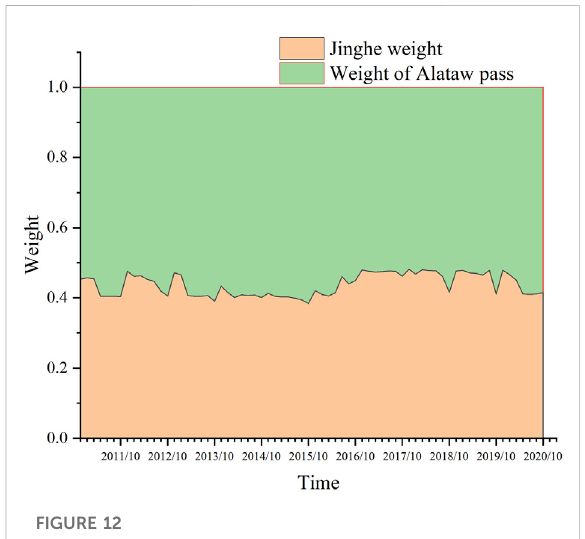
FIGURE 12 Weighted diagram of Jinghe and Alashankou Stations.